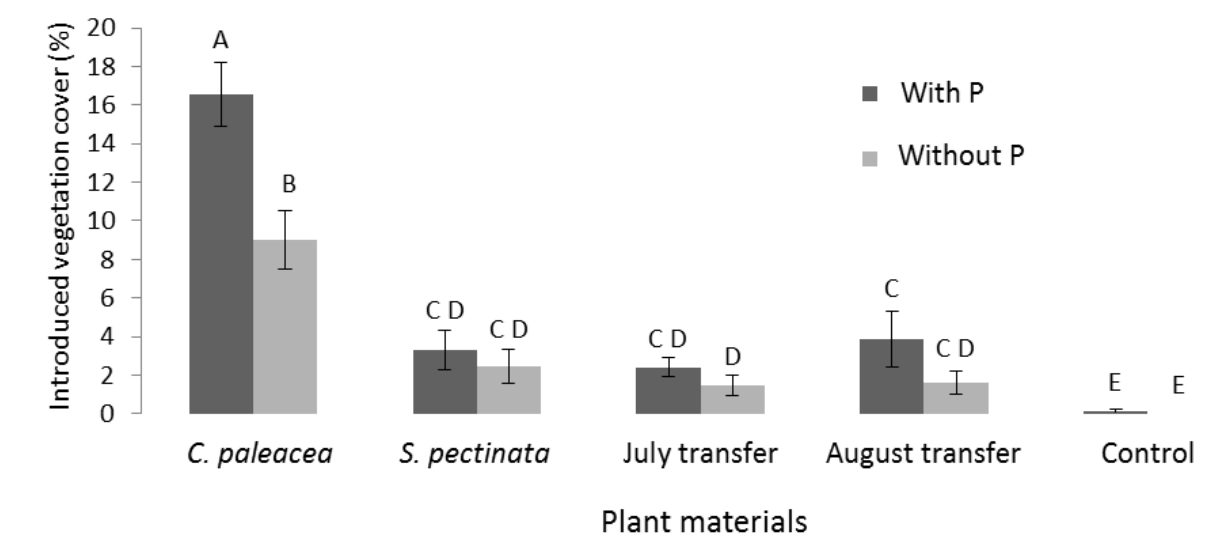
Figure 3. Mean percent cover of introduced vegetation according to the type of salt marsh plant material transferred and phosphorus fertiliser additions (error bars: ± SE). Carex paleacea and S. pectinata were transplanted at the beginning of July 2011, whereas salt marsh diaspores were spread in mid-July and mid- August 2011. Plant cover was recorded in mid-summer 2012. Different capital letters indicate significant differences between treatments following protected LSD. ANOVAS for factorial block design on introduced vegetation cover: vegetation type ( F 4,57 = 46, p = < 0.001), phosphorus ( F 1,57 = 16, p = 0.004), interaction ( F 4,57 = 3.7, p = 0.019). Lime treatment did not significantly affect introduced vegetation cover, nor did it interact significantly with the other